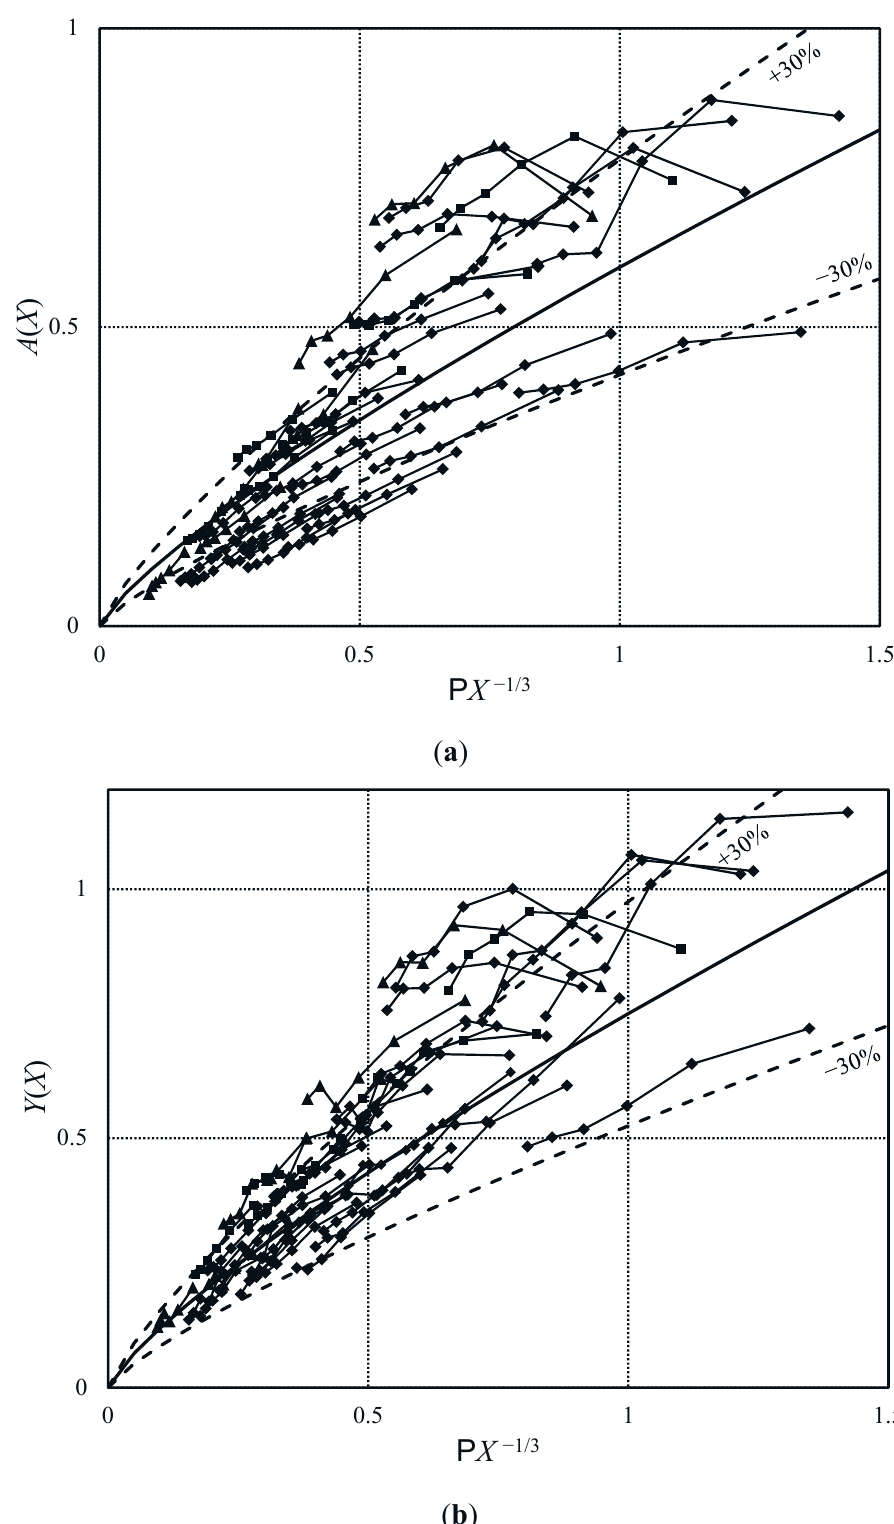
Figure 5. Mesh-packed slides ( a ) relative wave amplitude decay A ( X ) with ( ─ ) Equation (7); ( b ) relative wave height decay Y ( X ) with ( ─ ) Equation (8) versus P X  1/3 for α = 30° ( ▲ ), α = 45° ( ■ ), α = 60° ( ♦